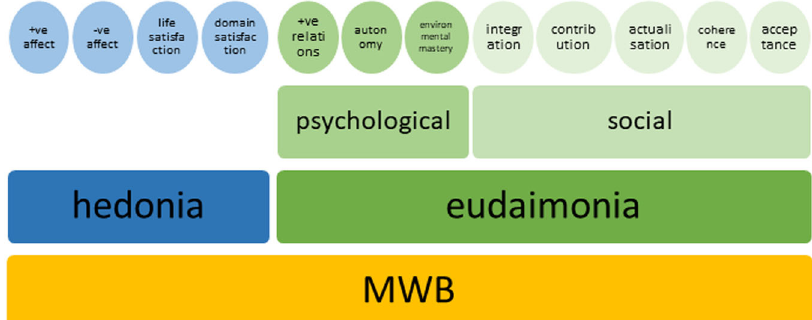
Fig. 1 Author ’ s graphical representation of Joshanloo et al. (2016) mental wellbeing (MWB) framework. The concept of mental wellbeing includes hedonic and eudaimonic concepts of wellbeing. Hedonia subsumes positive and negative affect, and life and domain satisfaction. Eudaimonia is split into psychological and social wellbeing. Psychological wellbeing encompasses positive relations with others, autonomy and environmental mastery. Social wellbeing comprises integration, contribution, actualisation, coherence and